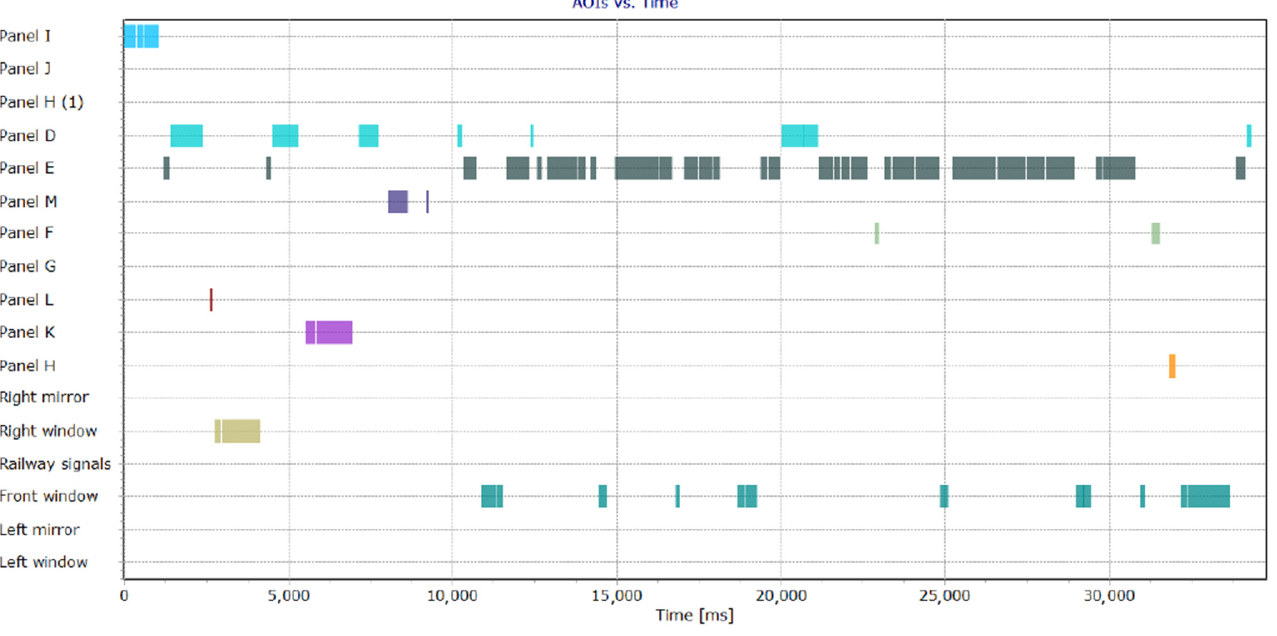
Figure 6. AOI sequence chart of average arrival procedure to railway stop Predmier.